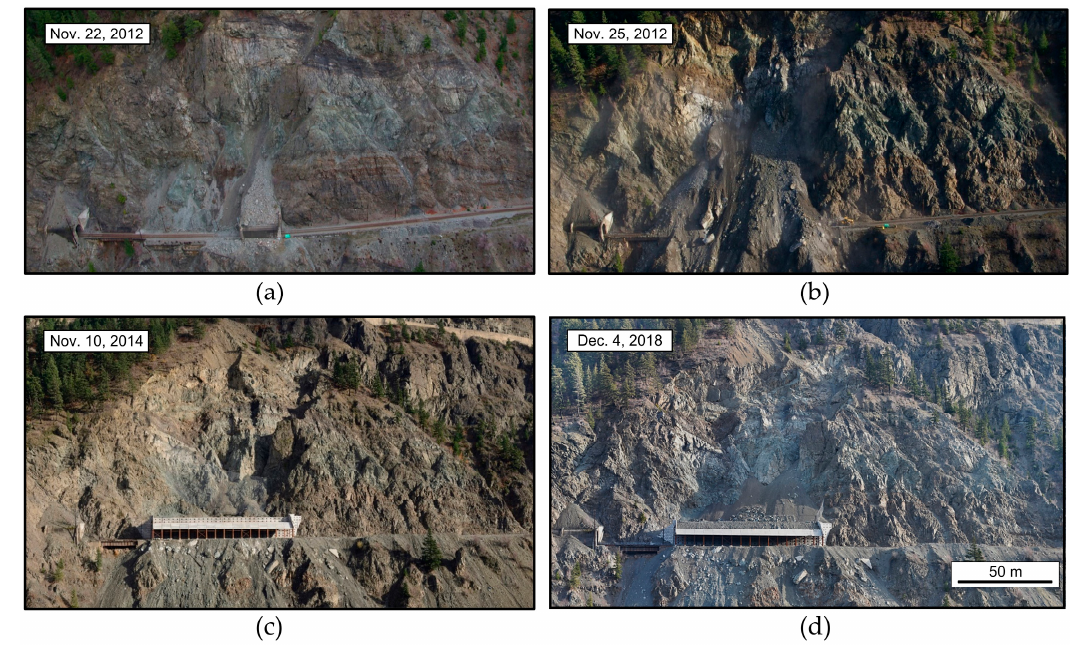
Figure 5. Site photos showing major natural and engineered slope changes at CN Ashcroft Mile 109.4 in the previous number of years. ( a ) 36 h before the 53,000 m 3 rockslide; ( b ) 12 h following